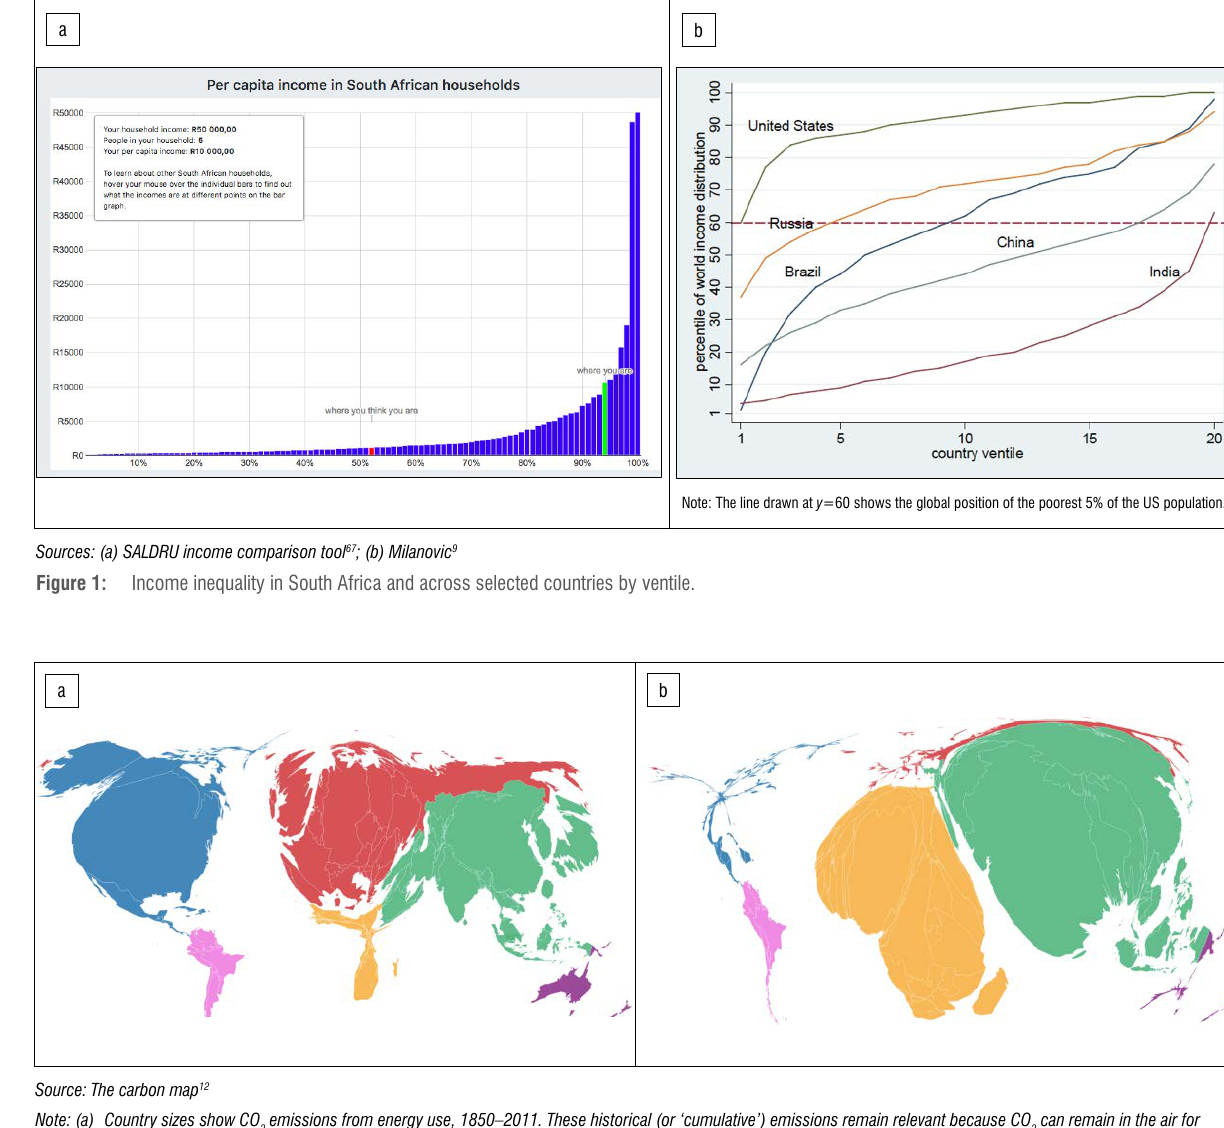
emissions and (b) 2